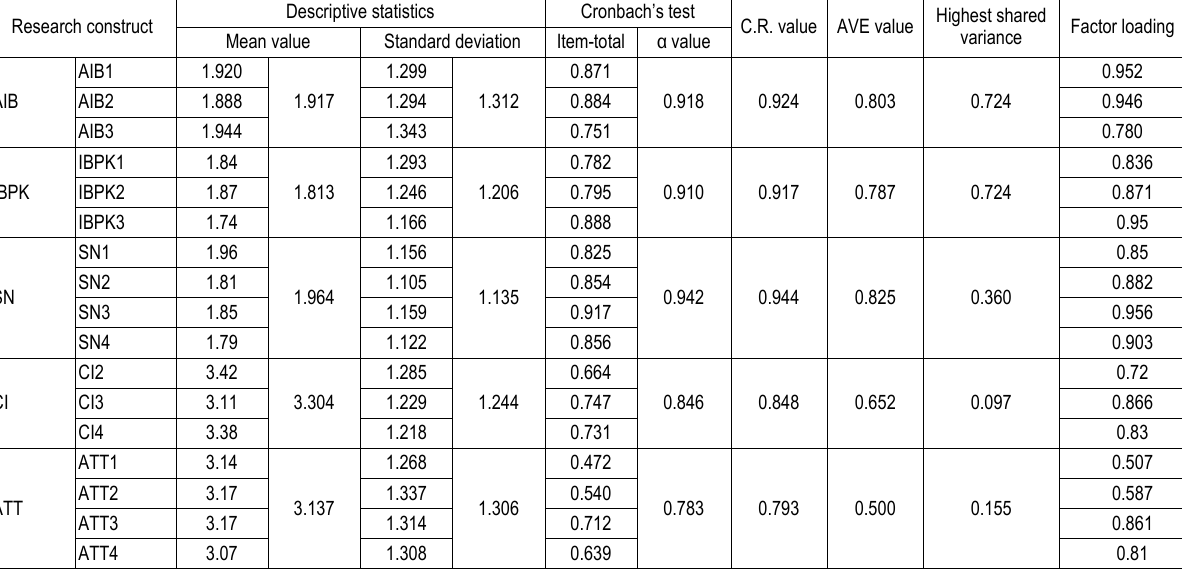
Table 3. Results of the accuracy analysis